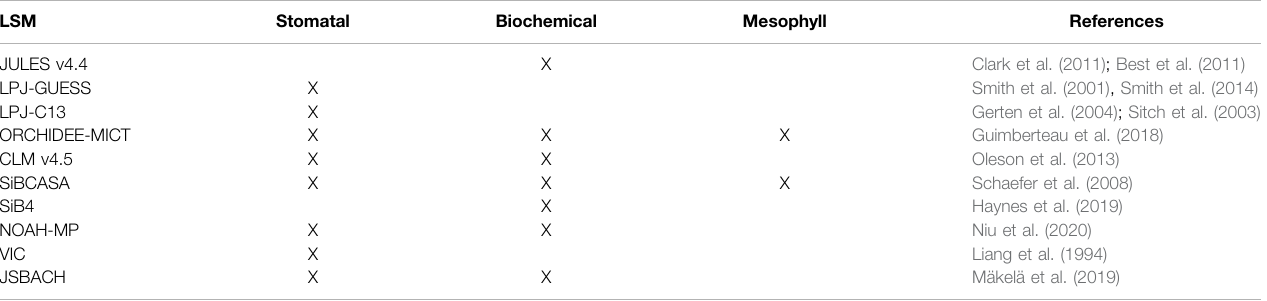
TABLE 1 | different strategies for imposing soil moisture stress on plants, as used in a number of current Land Surface Models (adapted and expanded from Peters et al., 2018).